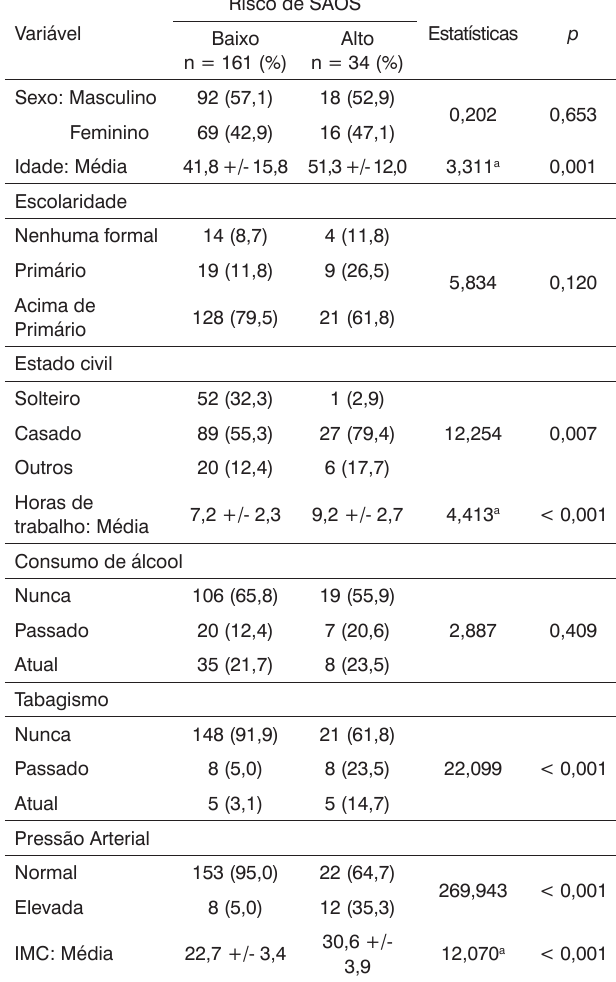
Tabela 3. Características em relação ao risco de